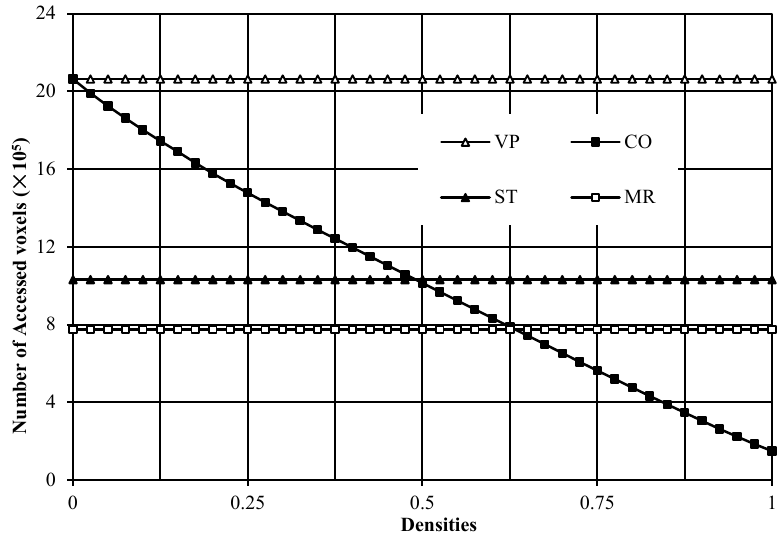
Figure 9. Number of accessed voxels in the compared algorithms.